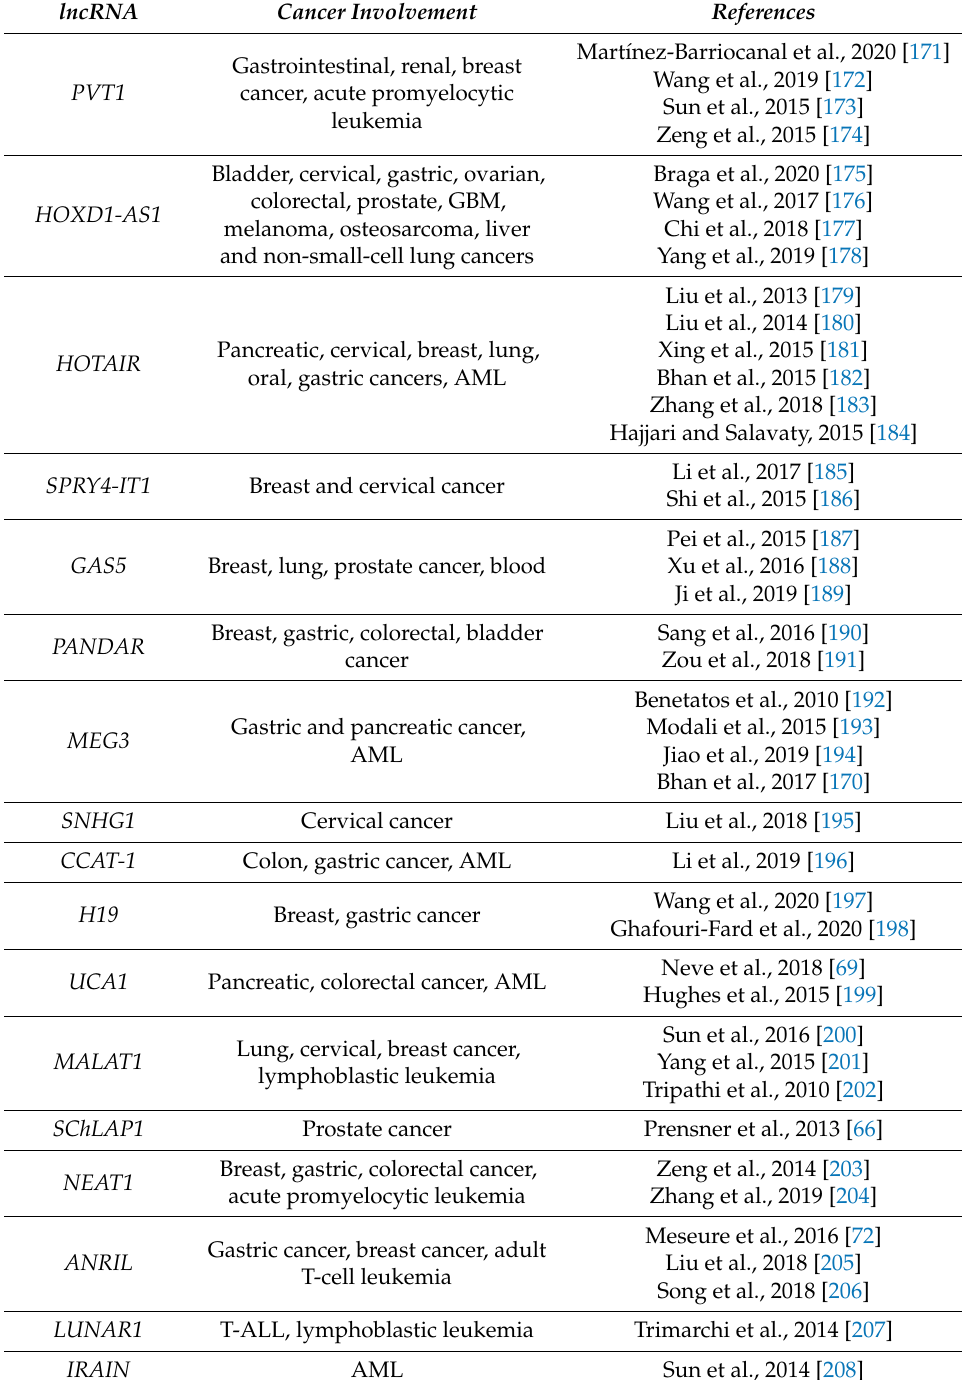
Table 4. LncRNAs implicated in diverse cancers. T-ALL: T-cell acute lymphoblastic